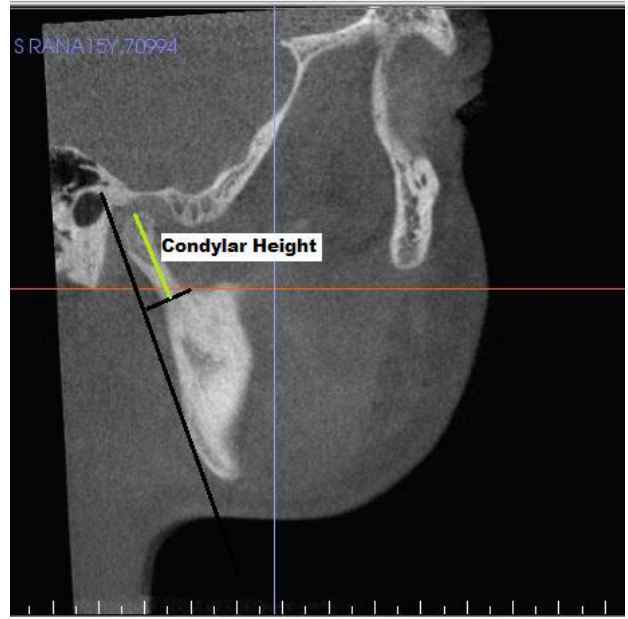
Figure 7. Condylar height measurement.